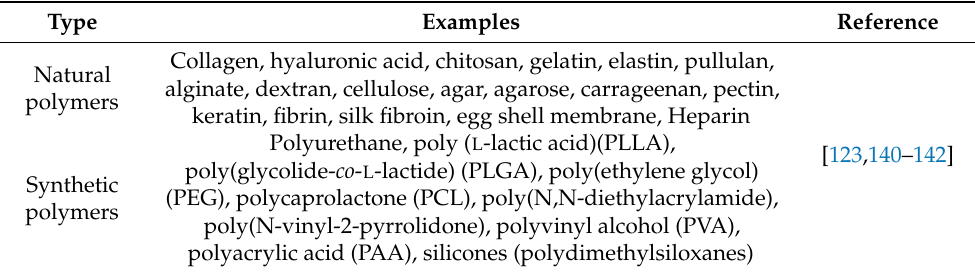
Table 5. Commonly used polymers for developing skin-mimicking